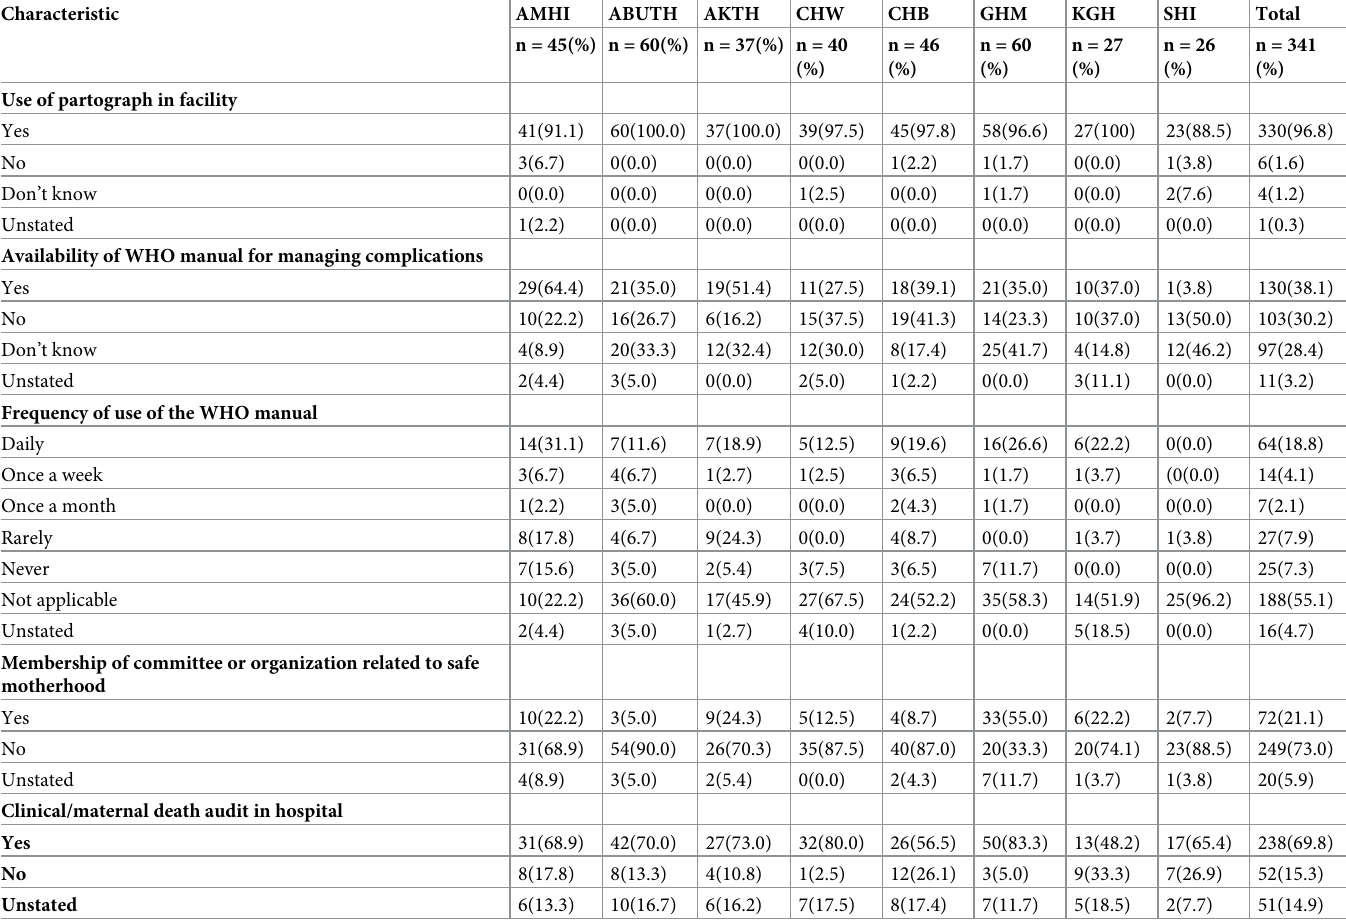
Table 2. Availability of protocols and policies on EMOC in the